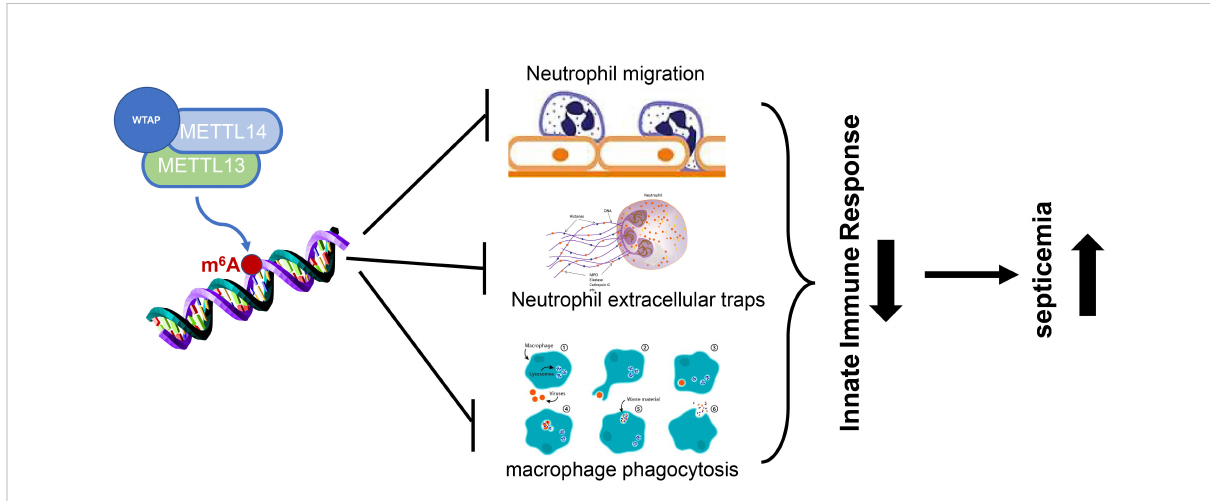
FIGURE 1 Schematic representation of the possible mechanisms of m6A methylation leading to